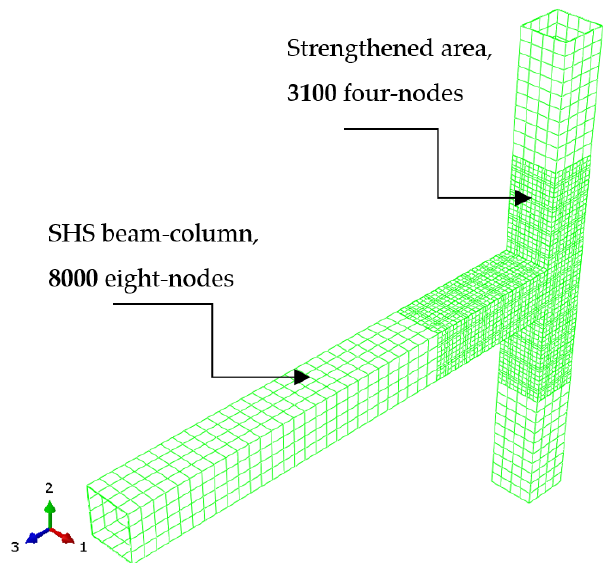
Figure 4. Finite element model .